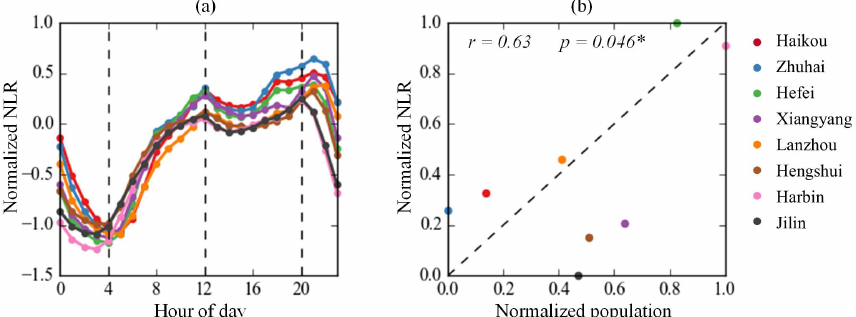
Figure 3. The diurnal variation patterns of the NLR in the eight cities (a) . A positive correlation between the NLR and the total number of residents (b) . Table 3. A number of different categories regarding rainstorms and their corresponding R pos and R neg values. Rainstorms No rainfall Moderate Heavy Violent Cities N